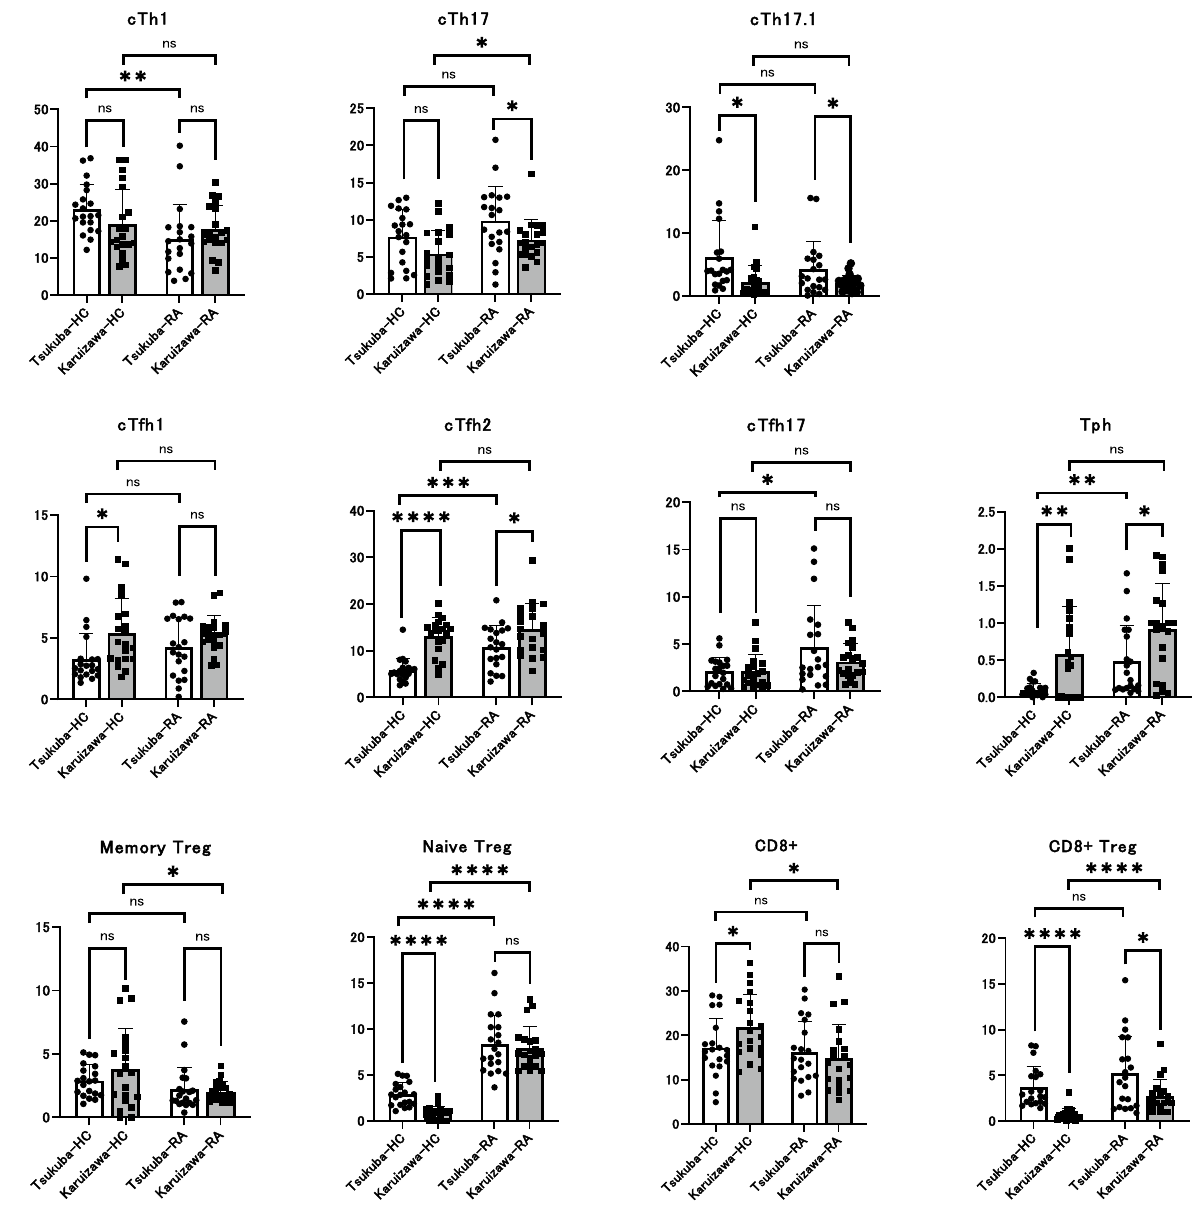
Figure 1. Differences in the proportion of subpopulations in peripheral blood T cells between RA patients and HCs from two distinct geographic locations. The proportion of T cell subpopulations in PBMC collected from RA patients and HCs in two hospitals was analyzed using flow cytometry. Histograms show percentage of cTh1 cells, cTh17 cells, cTh17.1 cells, cTfh1 cells, cTfh2 cells, cTfh17 cells, and cTph cells in memory CD4 + T cells, cTreg cells in naïve and memory CD4 + T cells, CD8 + T cells, and CD8 + Treg cells in CD8 + T cells. Data are presented as mean ± SEM, and circle and square shows samples collected from Tsukuba and Karuizawa, respectively. Unpaired t-test was performed to analyze statistical interactions between blood samples collected from HCs and RA patients in Tsukuba or Karuizawa. Statistical significance was defined as * P < 0.05, ** P < 0.01, *** P < 0.001, and **** P <